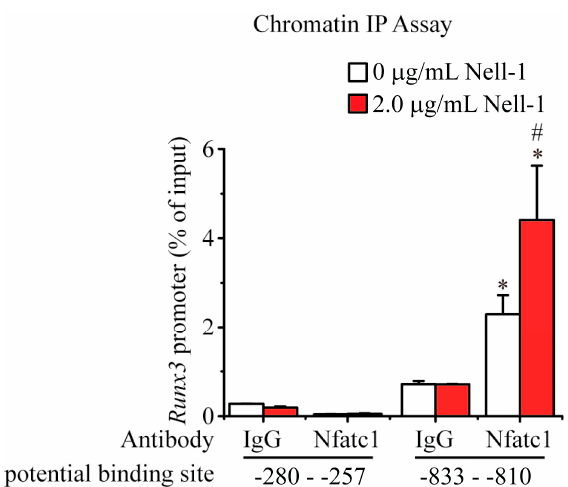
Figure 5. Nell-1 enhances the binding of Nfatc1 and Runx3 -promoter in Runx2 − / − rib chondrocytes. Chromatin Immunoprecipitation (ChIP) assay of Nfatc1’s binding affinity to two potential binding sites on the Runx3 promoter was performed in Runx2 − / − rib chondrocytes. *: p < 0.05 vs. IgG + 0 µg/mL Nell-1, # : p < 0.05 vs. Nfatc1 antibody + 0 µg/mL Nell-1. Mean + SD of three independent experiments performed in triplicate are shown.